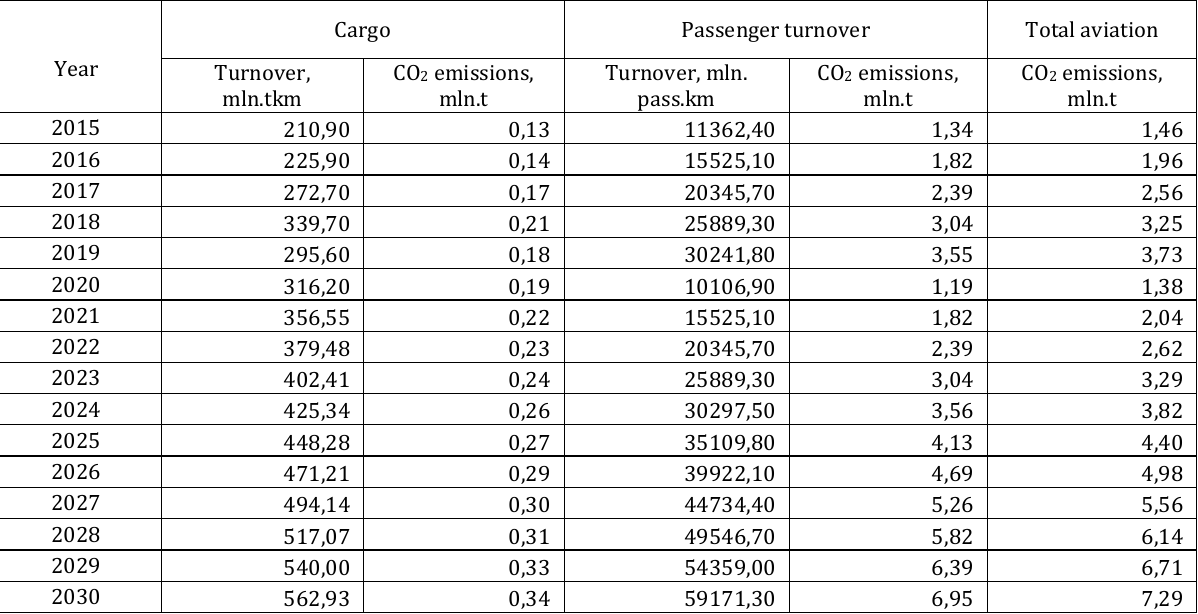
Table 4. Turnover and CO 2 emissions forecast for Ukraine to 2030